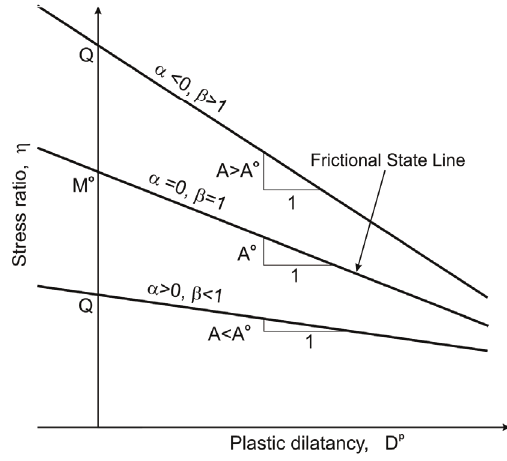
Fig. 3. Stress-plastic dilatancy relationships for different  and  parameters